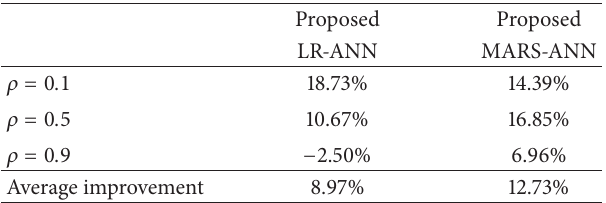
Table 12: AIR improvement of the proposed models in comparison with classical ANN